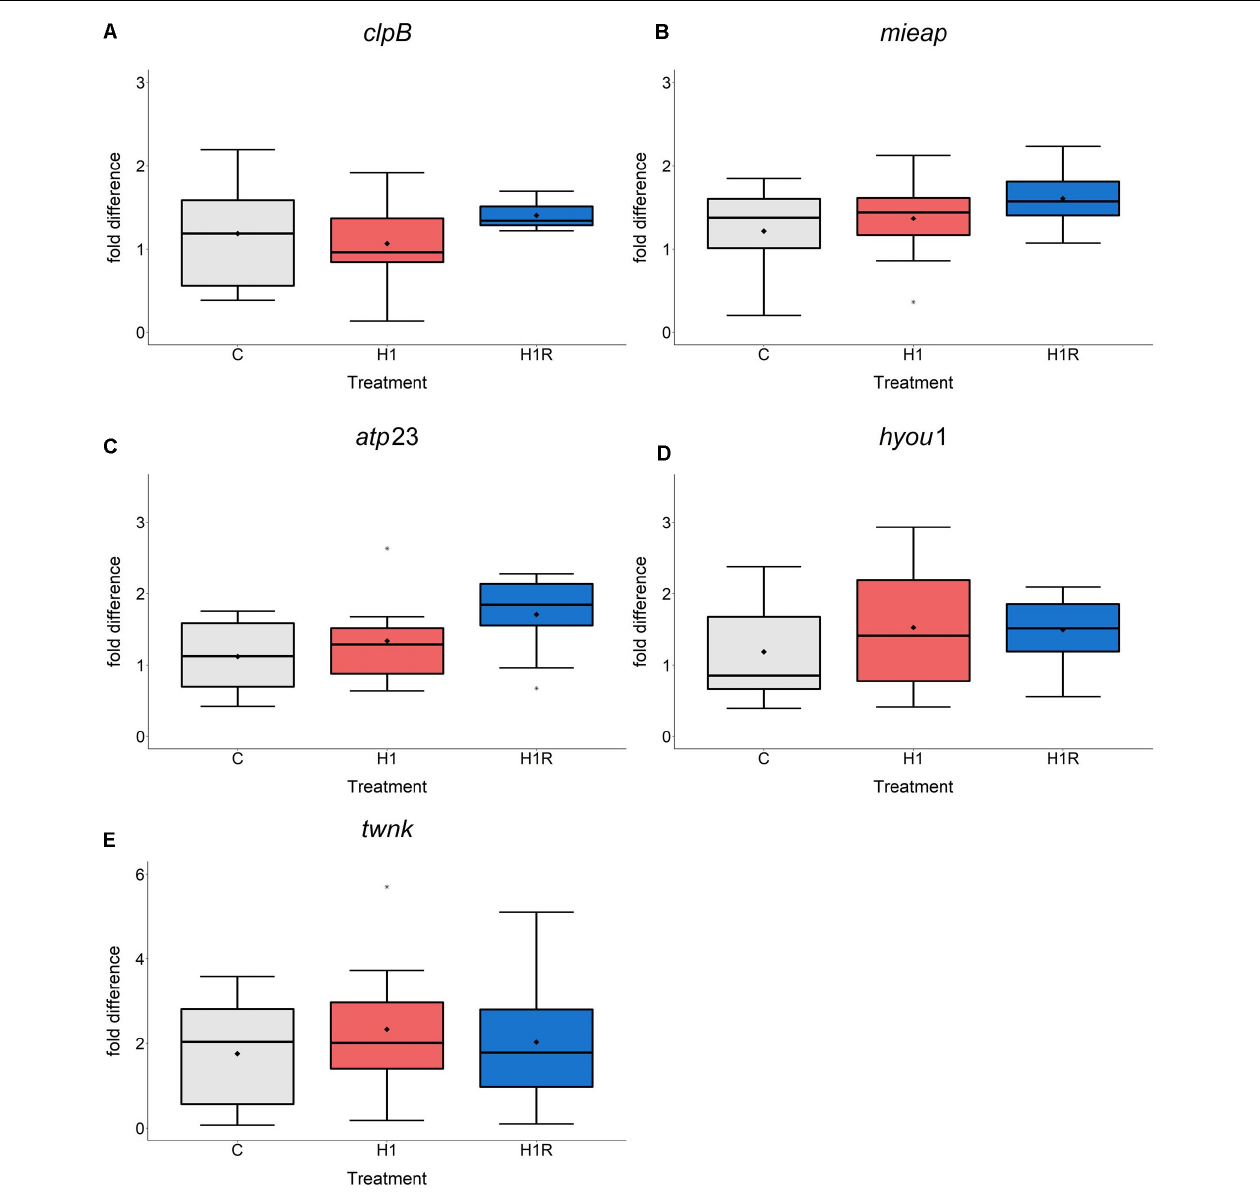
FIGURE 4 | mRNA expression of mitochondrial quality control proteolysis and mtDNA maintenance in C. gigas hepatopancreas in response to H/R stress. (A–D) C. gigas ; (A) clpB mRNA; (B) mieap mRNA; (C) atp 23 mRNA; (D) hyou 1 mRNA; (E) twnk mRNA. Experimental groups: C, control; H1, short-term (1 day) severe hypoxia; H1R, short-term (1 day) severe hypoxia and subsequent 1.5 h reoxygenation. Means are depicted as points within corresponding Box-Whisker-plot. Outliers are shown as asterisk (*). Different letters above plots represent values that are statistical significantly different from each other ( p < 0.05). Plots sharing a letter are not significantly different ( p > 0.05). N =